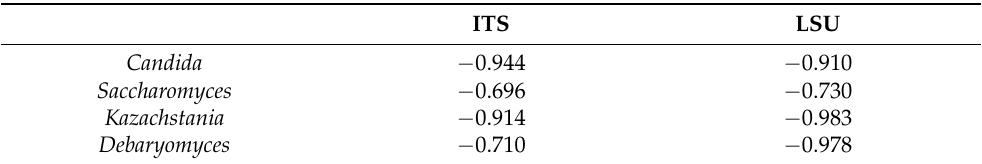
Table 2. Correlation between CI and maximum distance between species. Correlations were calcu- lated according to the Pearson moment using the distances and the relative CI values with CI < 1, i.e., for all values presenting some degree of homoplasy. ITS LSU Candida − 0.944 − 0.910 Saccharomyces − 0.696 − 0.730 Kazachstania − 0.914 − 0.983 Debaryomyces − 0.710 −